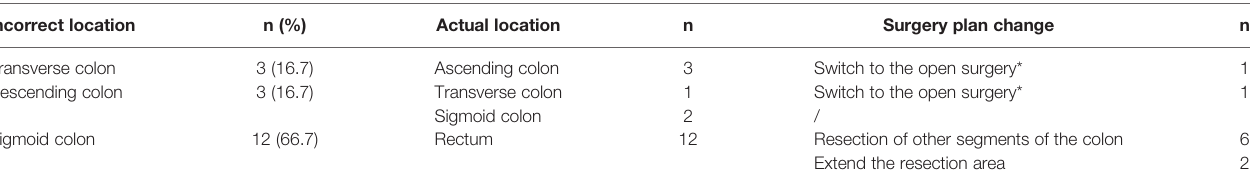
TABLE 4 | The incorrectly localized lesions and changes in the